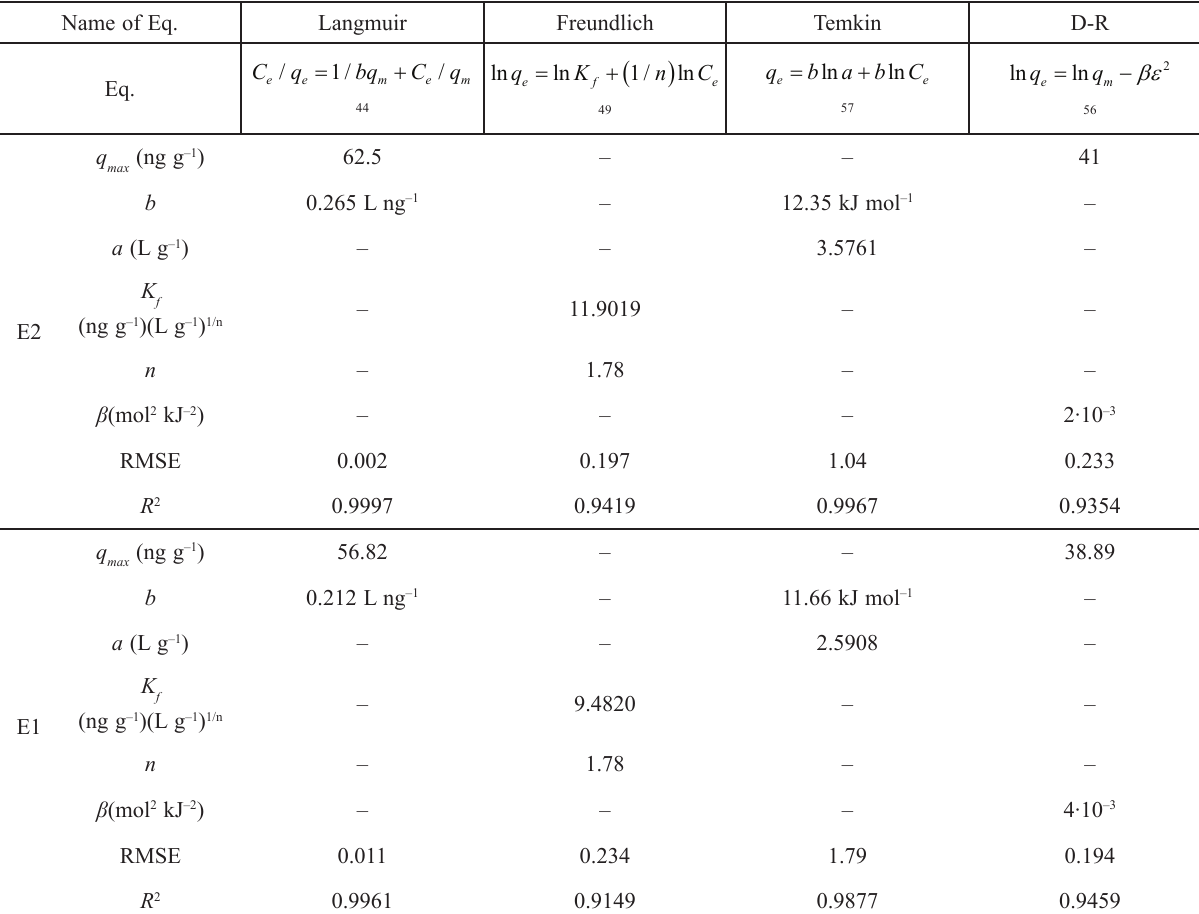
Table 3 – Results of adsorption isotherm models of E2 and E1 hormones on rice husk silica (adsorbent dosage of 1.5 g L –1 , pH of 4, and contact time of 60 min) D-RTemkinFreundlichLangmuirName of Eq.